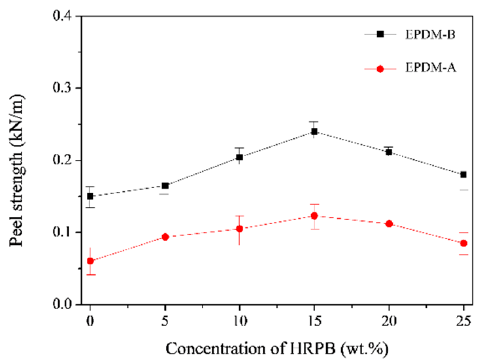
Figure 3. Peel strengths of CPP/Al foil laminates vs HRPB (wt.%) content of the adhesives, which were laminated with EPDM-B ( ■ ) or EPDM-A ( ● ). The failures occurred at interfaces of adhesives and Al foils regardless of concentration of